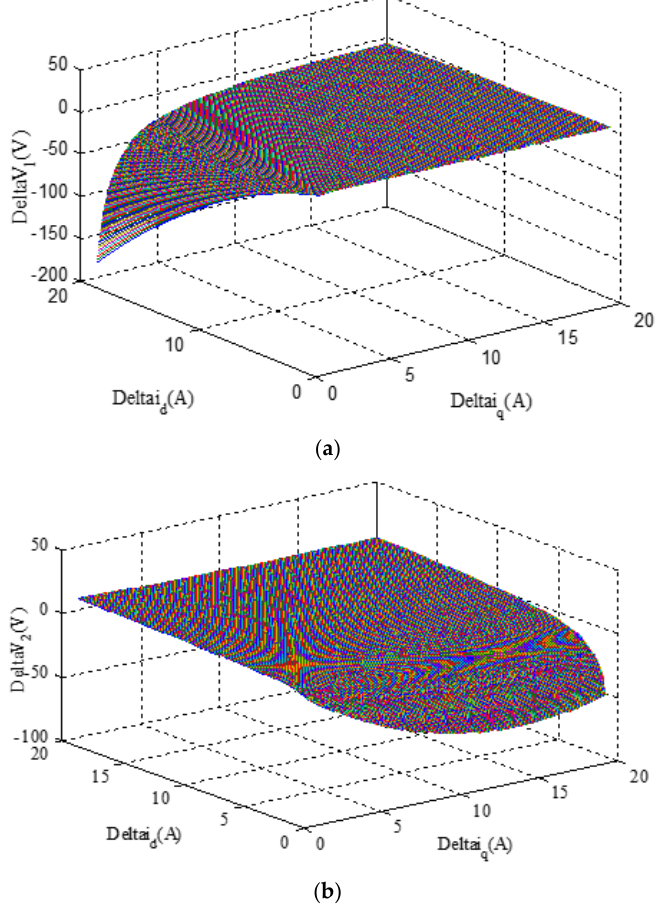
Figure 7. The current perturbation components effects on: ( a ) Δ v 1 ; ( b ) Δ v 2 . Table 1. The parameters and power values considered in simulation section.